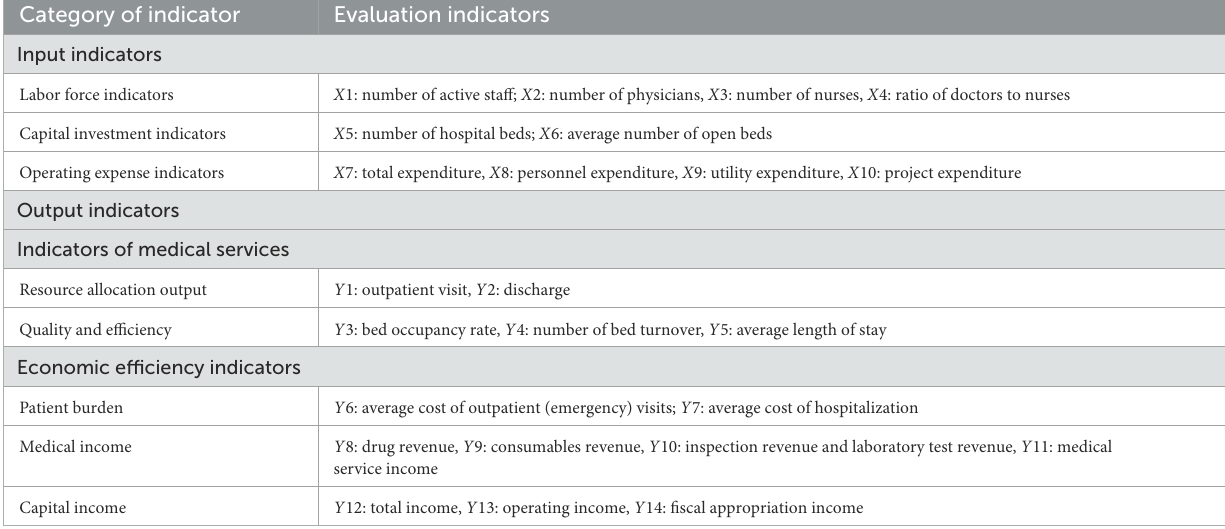
TABLE 1 Database of hospital management efficiency indicators. Category of